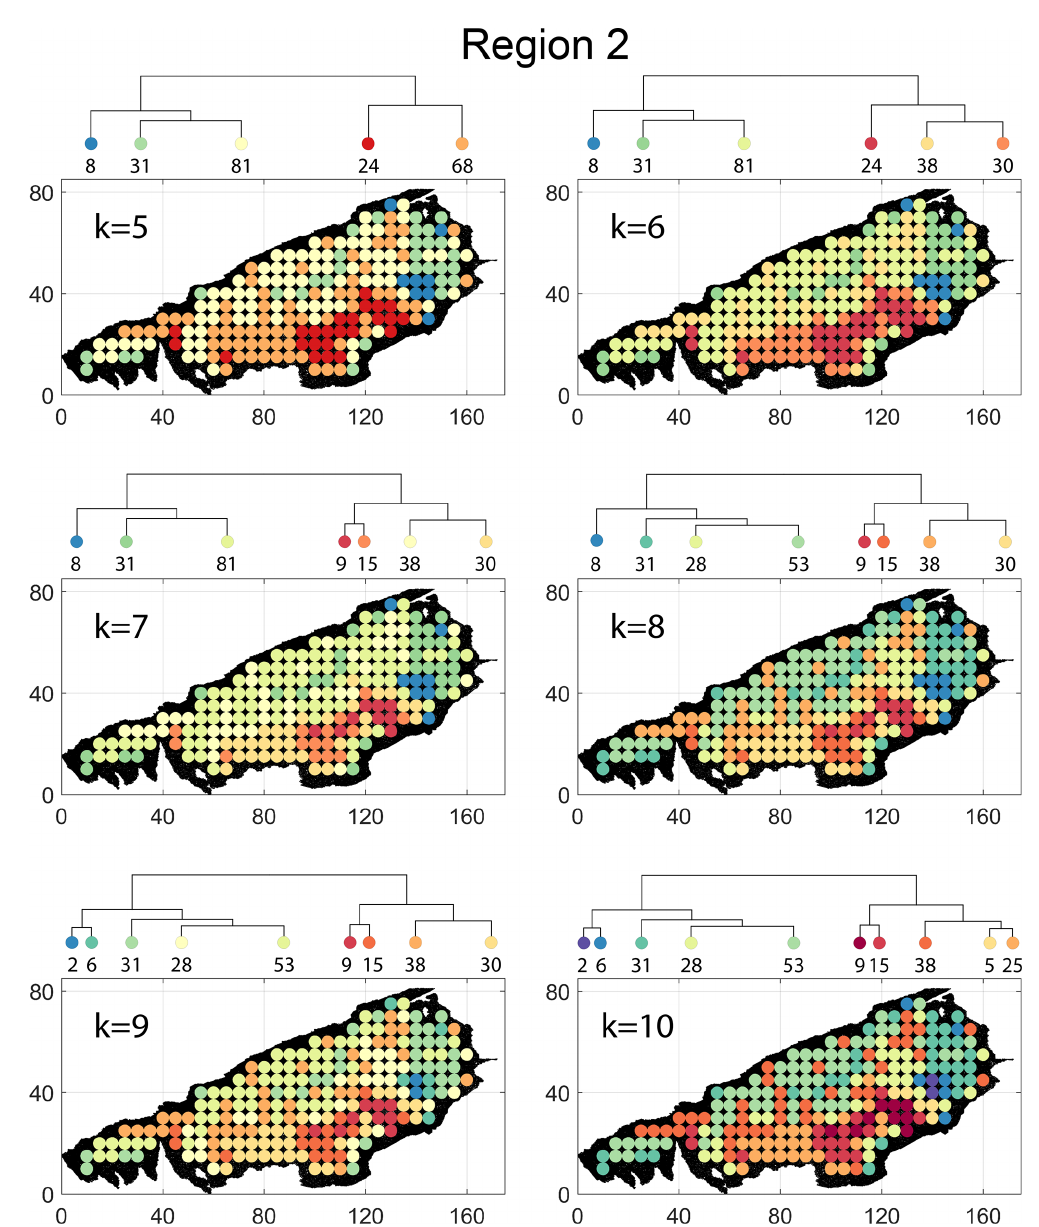
Figure B7. Variation in cluster boundaries for “ k ” clusters in Region 2 using NetLSD.